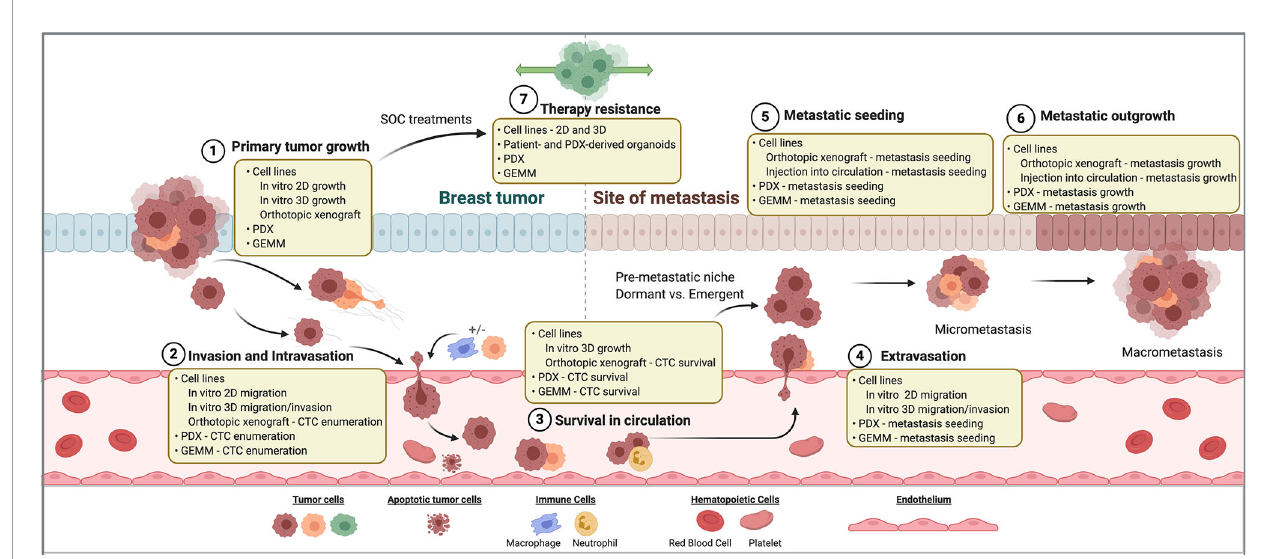
FIGURE 1 | Breast cancer models for investigating therapy resistance and metastasis. Steps of the metastatic cascade and SOC therapy resistance are diagrammed. For each step, classes of laboratory models that may be used to investigate its biology are listed. SOC, standard of care. PDX, patient-derived xenograft. GEMM, genetically engineered mouse model. CTC, circulating tumor